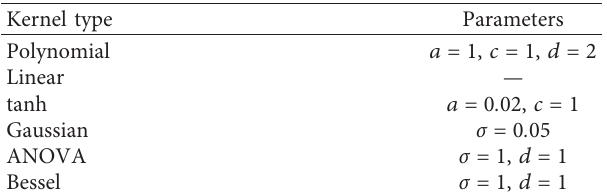
Table 4: Parameters used in the KSVMQR model with different